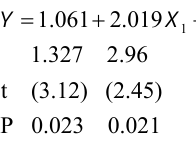
Sum of Squares df Mean of Squares